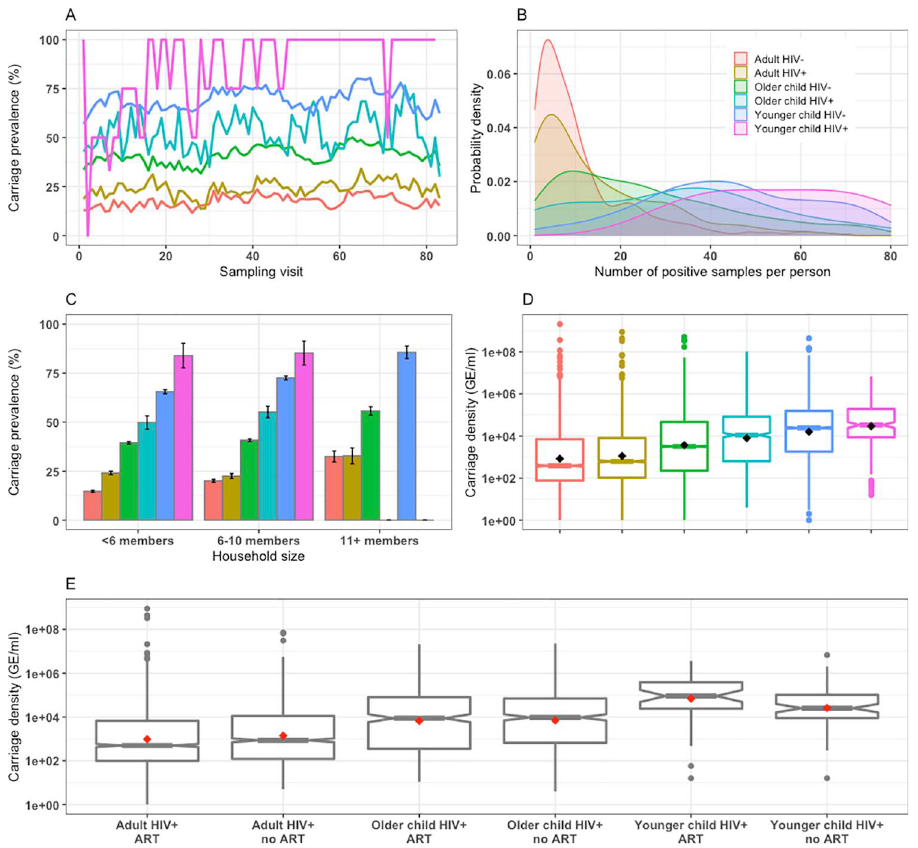
Fig 2. Human immunodeficiency virus (HIV)-stratified pneumococcal carriage dynamics in younger children ( < 5 years-old), older children (5–17 years-old) and adults ( � 18 years-old) in South African households between 2016– 2018. Age and HIV-stratified pneumococcal carriage prevalence by different nasopharyngeal sampling visits (A), the likelihood of detecting pneumococcal carriage during visits (B), pneumococcal carriage prevalence by household sizes with 95% confidence intervals (CI) (C) and carriage densities with mean (black diamond), median and associated 95% CI of median, 25 th and 75 th percentiles, minimum and maximum, and outlier where carriage density is measured as genome equivalents per millilitre (GE/ml) (D). Age and antiretroviral therapy (ART) stratified carriage density with mean (red diamonds), median and associated 95%CI of median, 25 th and 75 th percentiles, minimum and maximum, and outlier (notched boxplot)